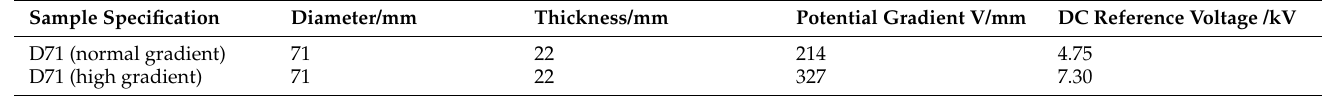
( b ) Figure 5. Power variation curve of D71 valve plate. ( a ) Power characteristics of general plate; ( b ) Power characteristics of high-gradient plate When the voltage frequency in the zinc oxide valve sample was fixed, the total leakage current value flowing through the valve sample was approximately proportion- al to the amplitude of the voltage applied at both ends of the sample; that is, when the voltage frequency was fixed, the internal impedance and internal resistance of the zinc oxide valve sample were basically unchanged with the increase in the amplitude of the applied voltage. When the voltage amplitude was the same, an increase in applied volt- age frequency resulted in a decrease in the internal impedance of the zinc oxide valve, as well as the resistive component. 4. Material Characteristics and Microscopic Characteristics of a High-Gradient Valve Slice